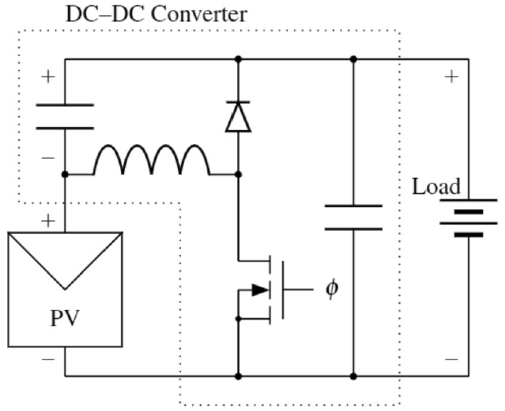
Figure 1. A diagram of the PV energy harvesting system with boost converter, where the gate of the transistor is driven by a gate driver circuit ( φ ) and controlled by a